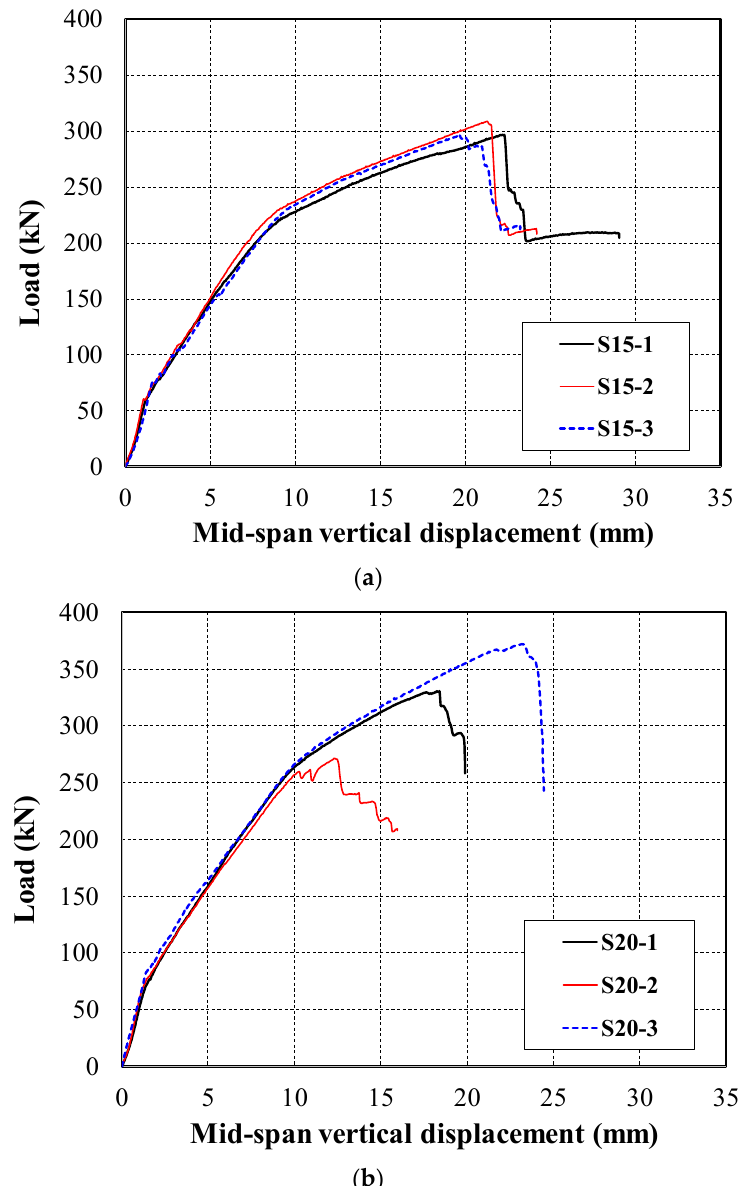
Figure 9. Load versus mid-span displacement curves of the specimens. ( a ) S15 series; ( b ) S20 series.